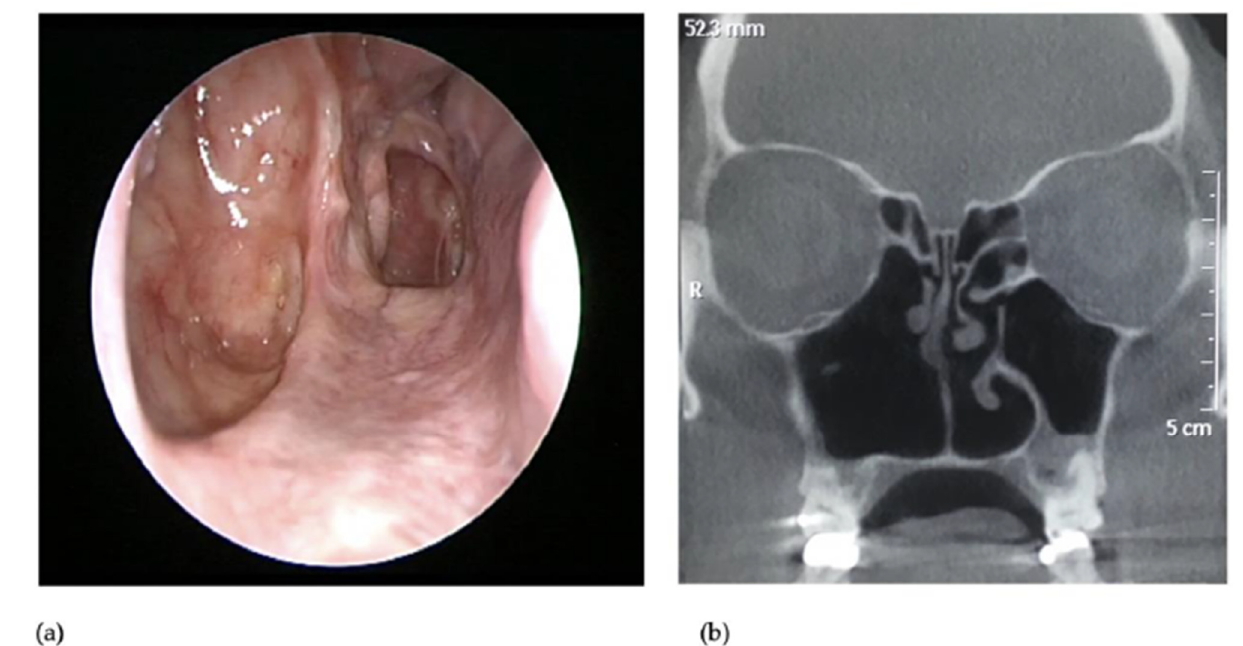
Figure 6. ( a ) Nasoendoscopic view and ( b ) computed tomography demonstrating excellent access for disease monitoring post right medial maxillectomy.